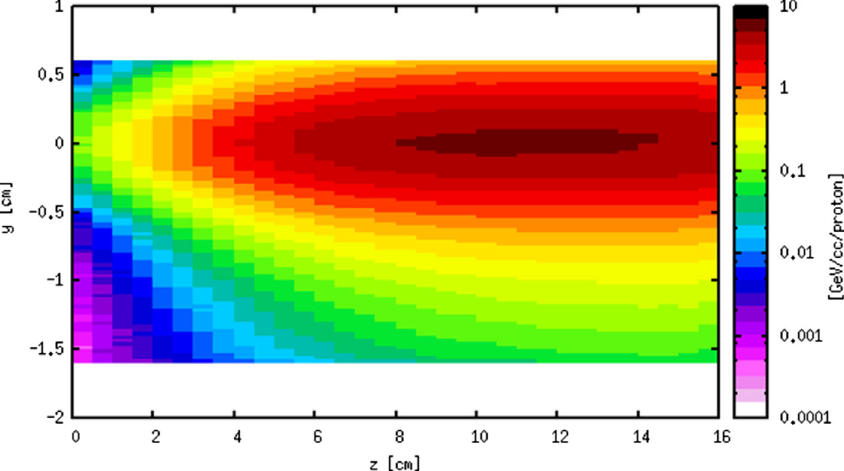
FIG. 2. Energy deposition in the tungsten powder and helium compound calculated with FLUKA ( x ¼ 0